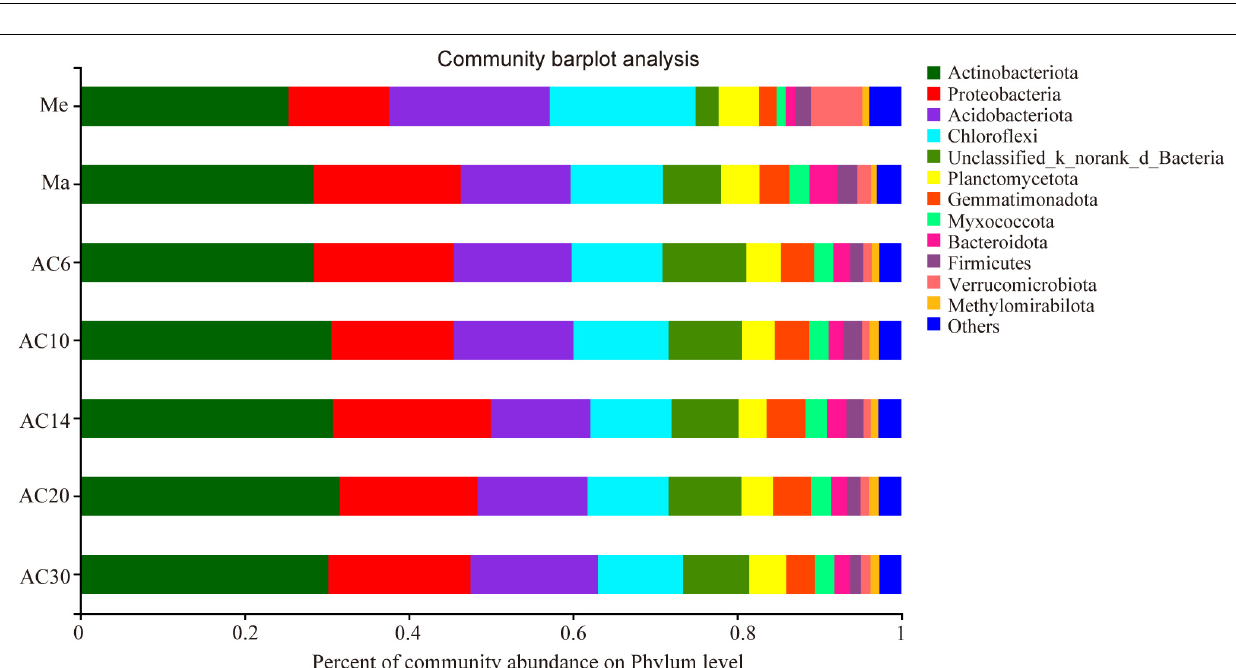
FIGURE 1 | Effect of crop type and continuous cropping years on the bacterial Chao1 richness (A) and Shannon diversity (B) .